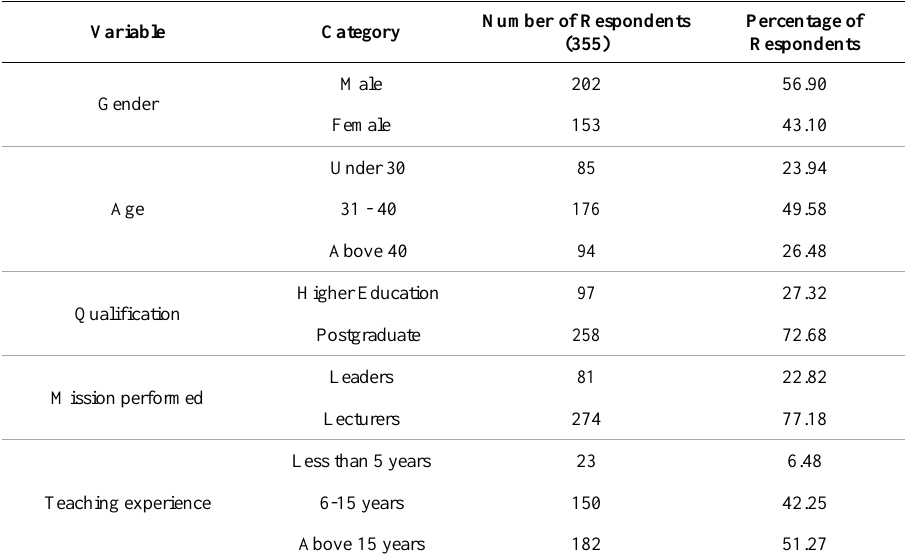
Table 2. Demographic characteristics of